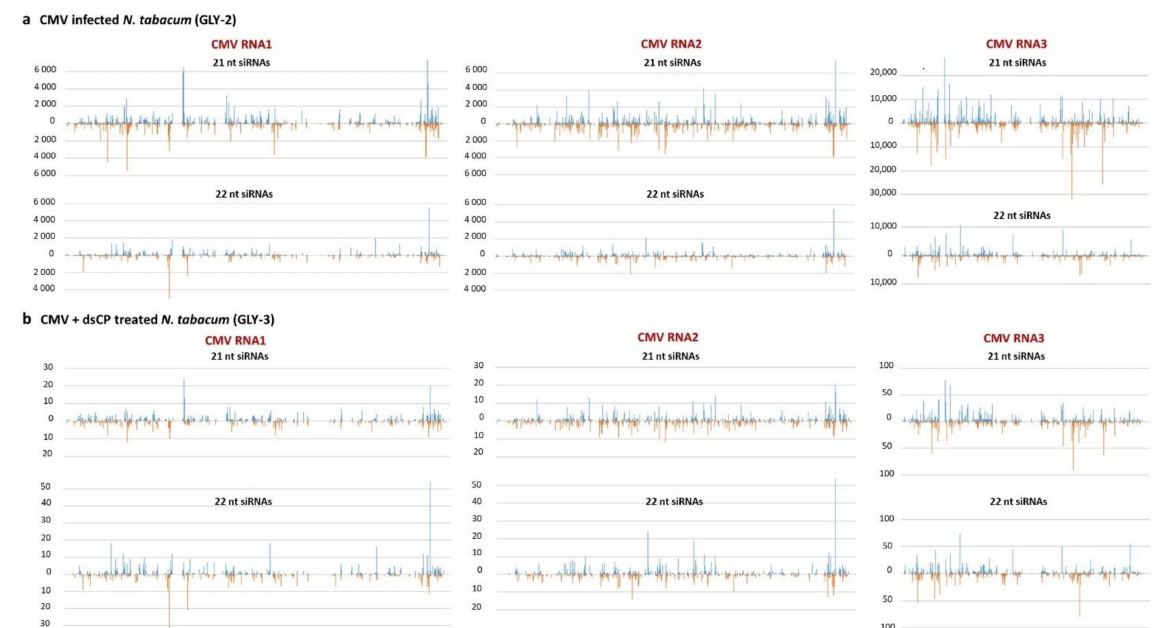
Figure 6. Single-nucleotide resolution maps of virus-derived small interfering RNAs (siRNAs) from: ( a ) CMV-infected (GLY-2) and ( b ) in vivo dsCP treated (GLY-3) tobacco plants. For each plant sample, the histograms plot the numbers of 21 and 22 nt viral siRNA reads at each nucleotide position of the CMV genomic RNAs RNA1 (3361 nt), RNA2 (3060 nt), and RNA3 (2216 nt) (mapped with up to 2 mismatches). The bars above the axis represent sense (forward) reads starting at each position and those below represent antisense (reverse) reads ending at the respective